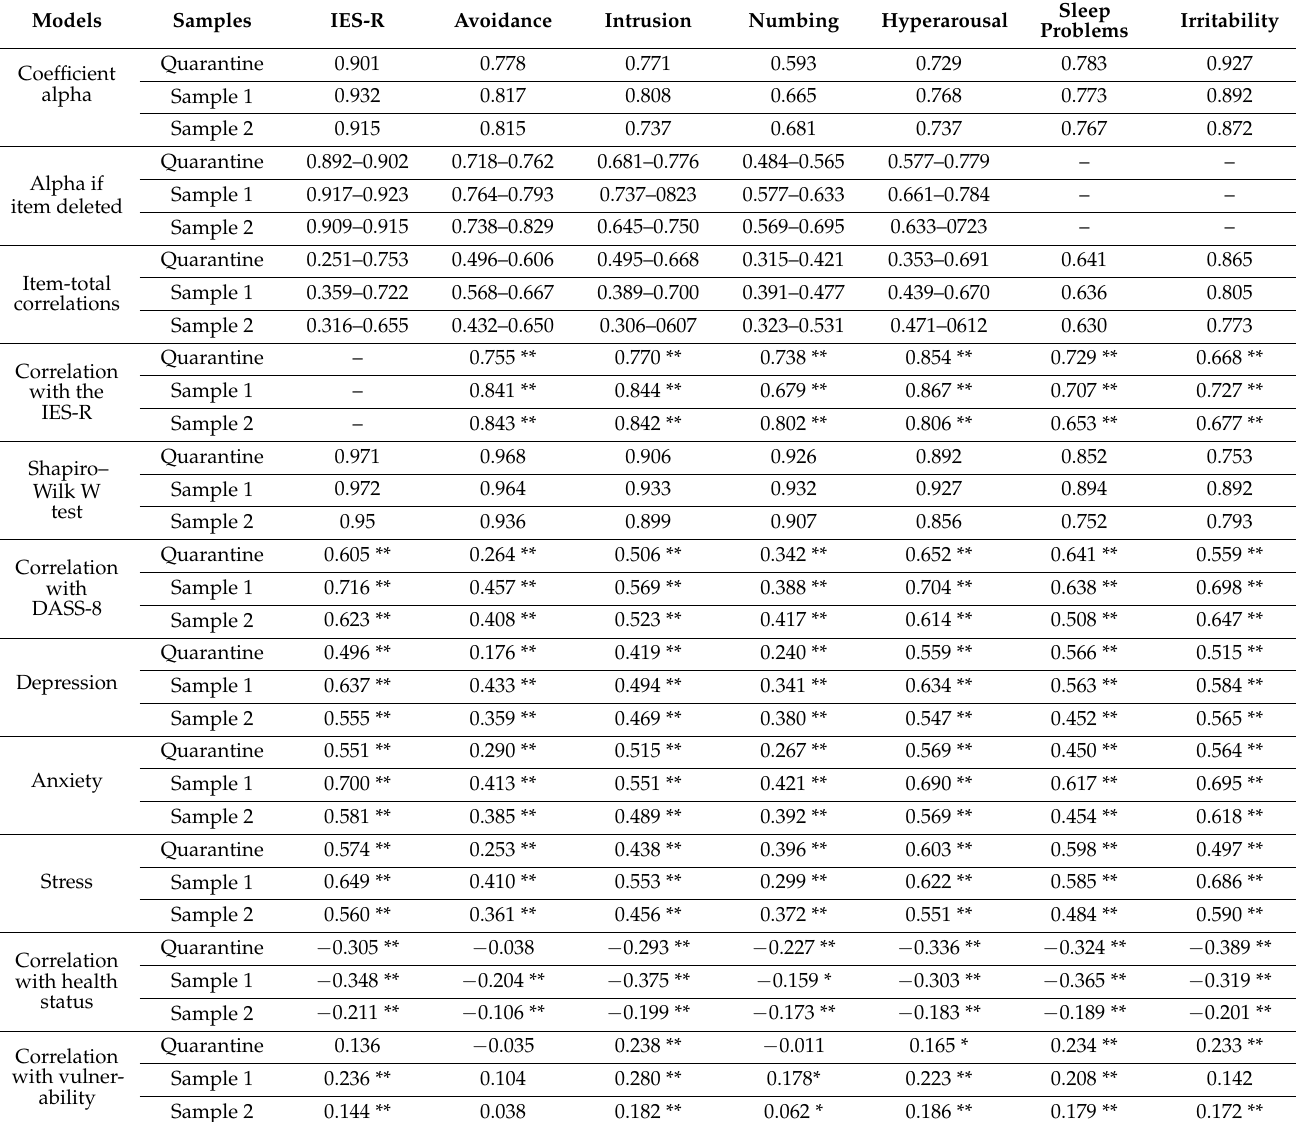
Table 6. Internal consistency, normality, and criterion validity of the Arabic version of the Impact of Event Scale-Revised (IES-R) and the factors it